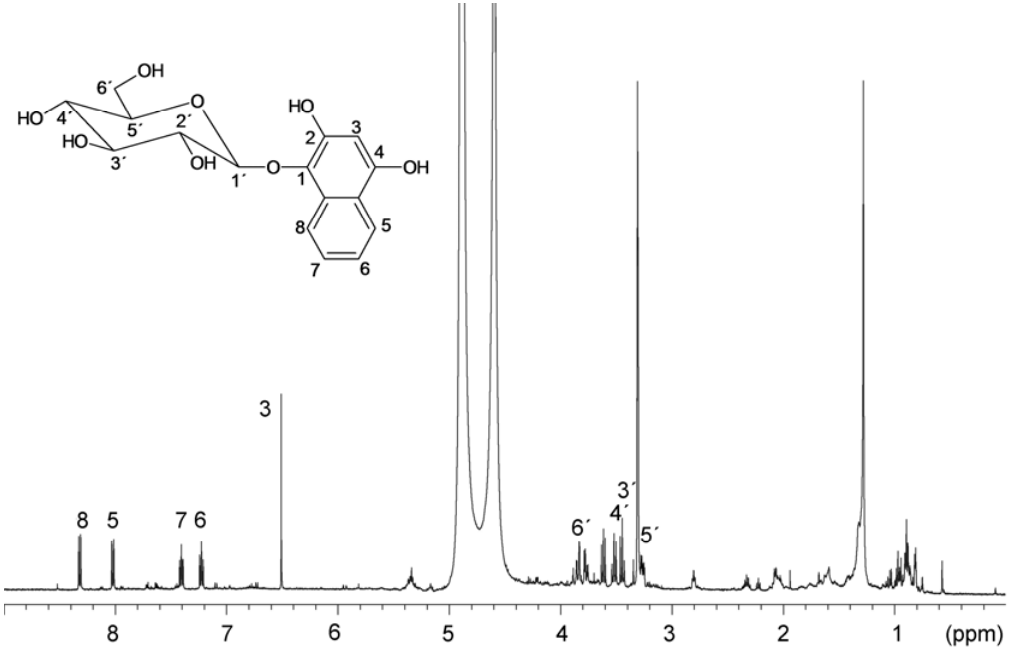
Figure 4. 1 H-NMR spectrum and the signal assignment of 1,2,4-trihydroxynaphthalene-1- O -glucoside.